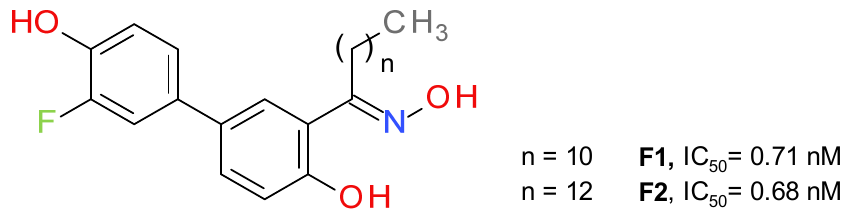
Figure 8. Reversible MAGL inhibitors—salicylketoxime derivatives.